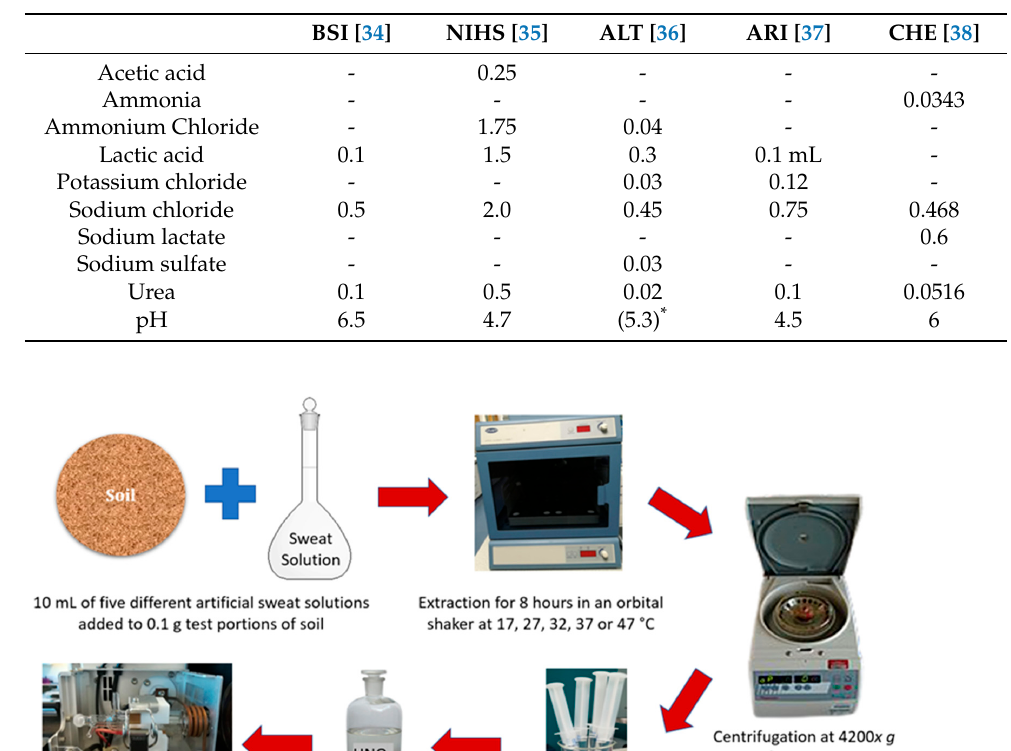
Table 1. Composition of the artificial sweat solutions (grams of reagent used to prepare 100 mL of solution unless otherwise stated).